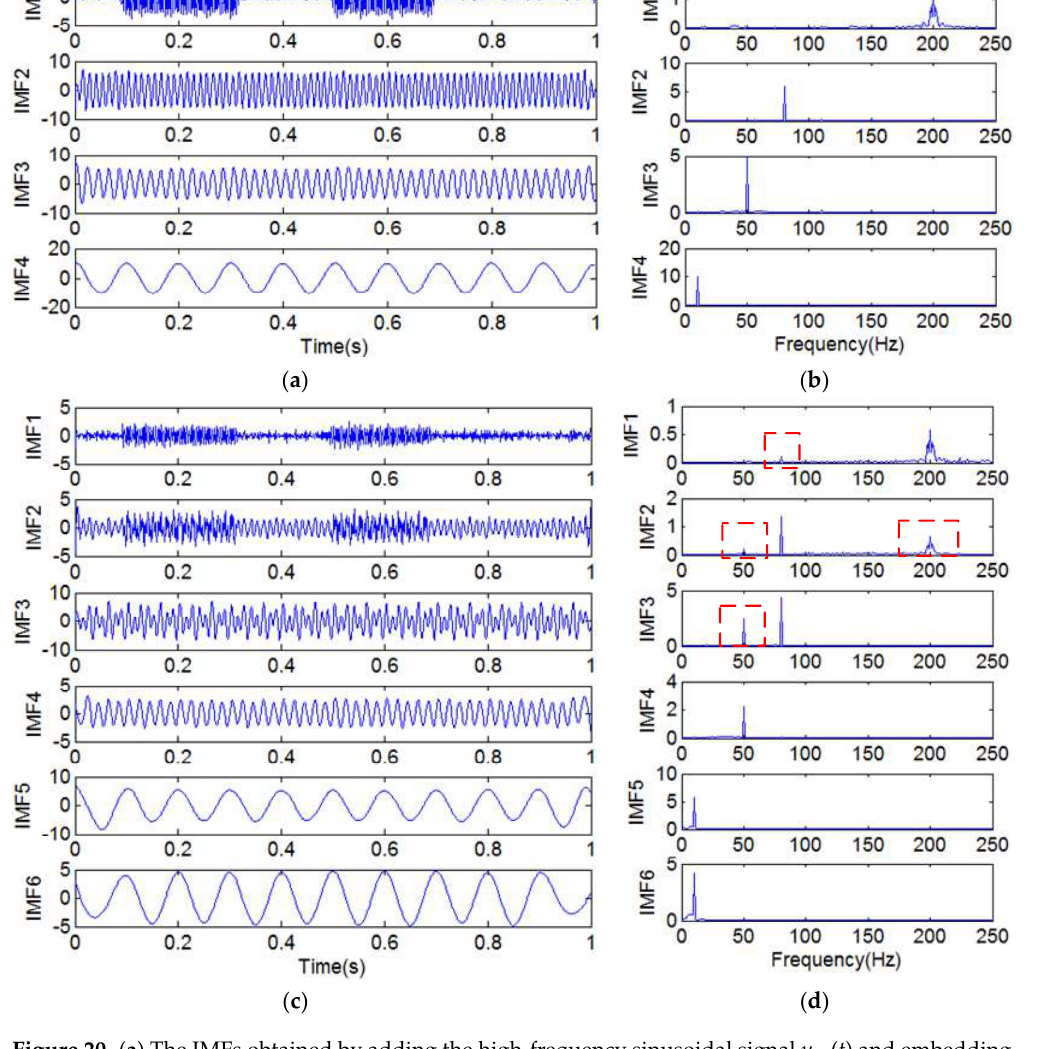
Figure 20. ( a ) The IMFs obtained by adding the high-frequency sinusoidal signal y 14 ( t ) and embedding a decorrelation operator; ( b ) the frequency spectrum corresponding to each IMF in ( a ); ( c ) the IMFs obtained by the ensemble empirical mode decomposition (EEMD) method; ( d ) the frequency spectrum corresponding to each IMF in ( c ).